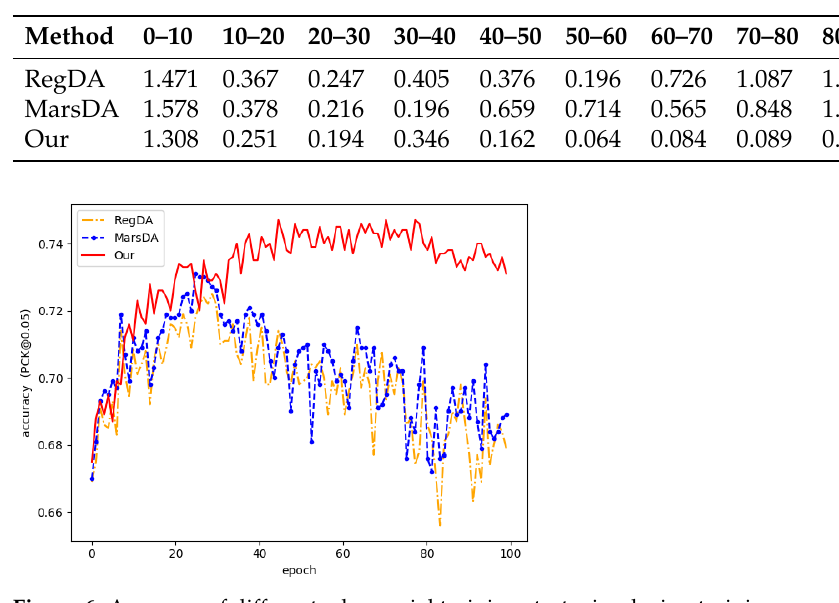
Table 4. Model Robustness Analysis.